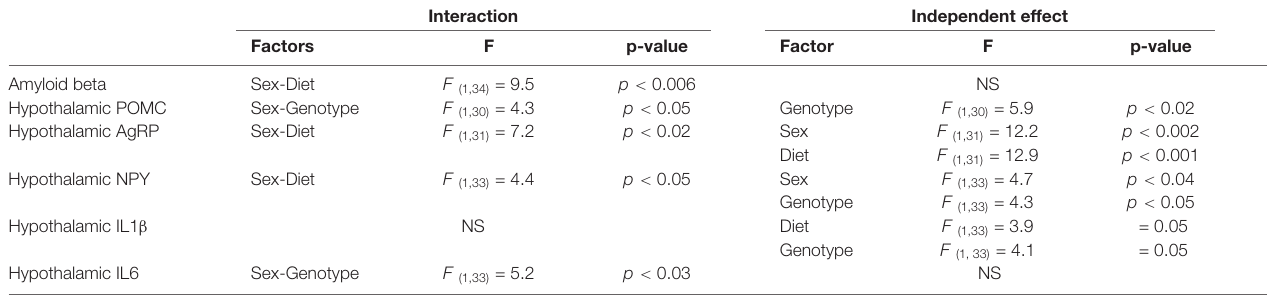
Sex-Genotype F (1,33) = 5.2 p < 0.03 NS NS, not significant.